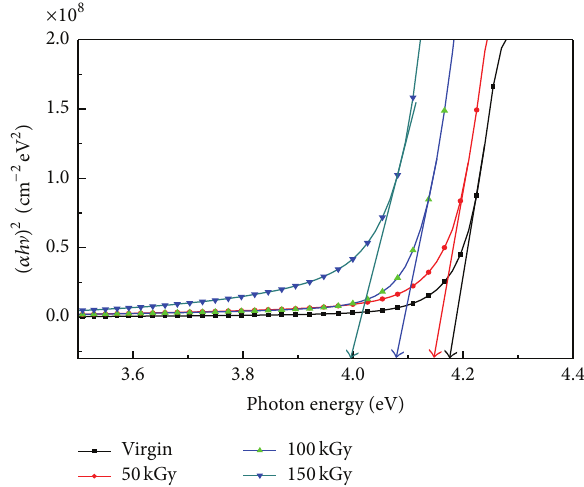
Figure 2: Variation of (𝛼ℎ ] ) 2 as a function of the photon energy ℎ ]